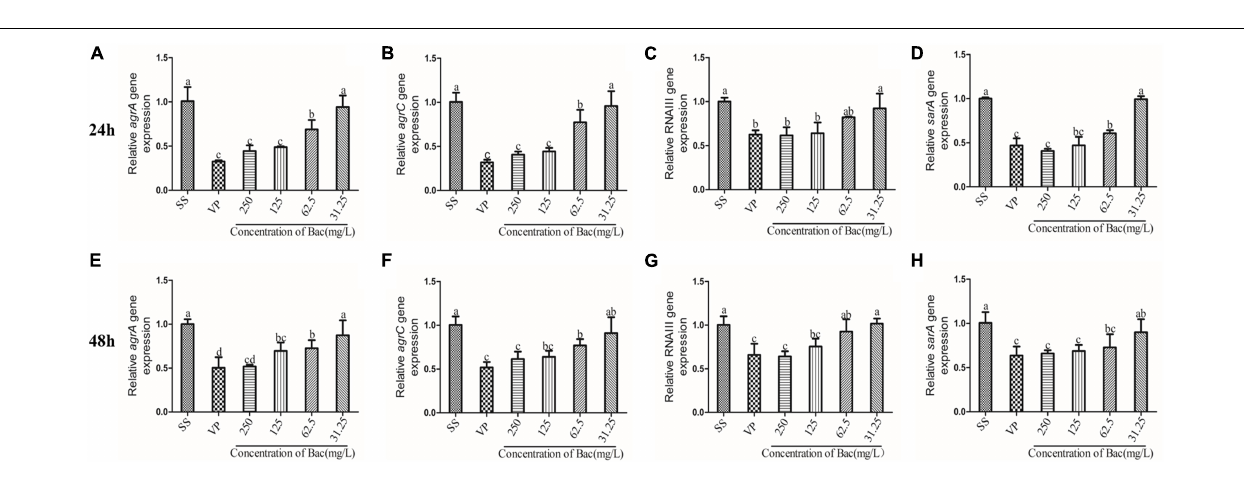
FIGURE 9 | Relative expression of the agr system-associated genes (using 16S rRNA as the internal parametric gene). The expression levels of agr A (A,E) , agrC (B,F) , RNA III (E,G) , and sarA (D,H) were determined in samples prepared from 24 h (A–D) and 48 h (E–H) ARSS biofilms in BHI using quantitative RT-PCR. Data are derived from three biological repeats. Bars in the same index without the same letters differ significantly ( p < 0.05).